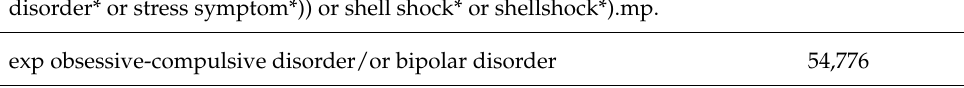
Table 1. Medline search strategy. Search Strategy Results exp *Stress Disorders, Post-Traumatic/or (PTSD or ((posttraumatic